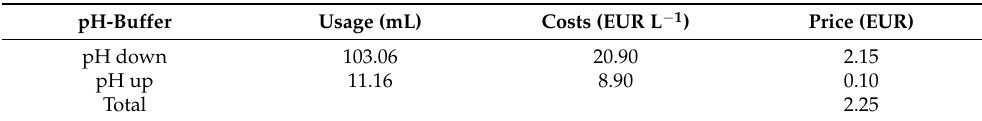
Table 5. SOF inputs: pH-buffer used in this study and their implied costs.